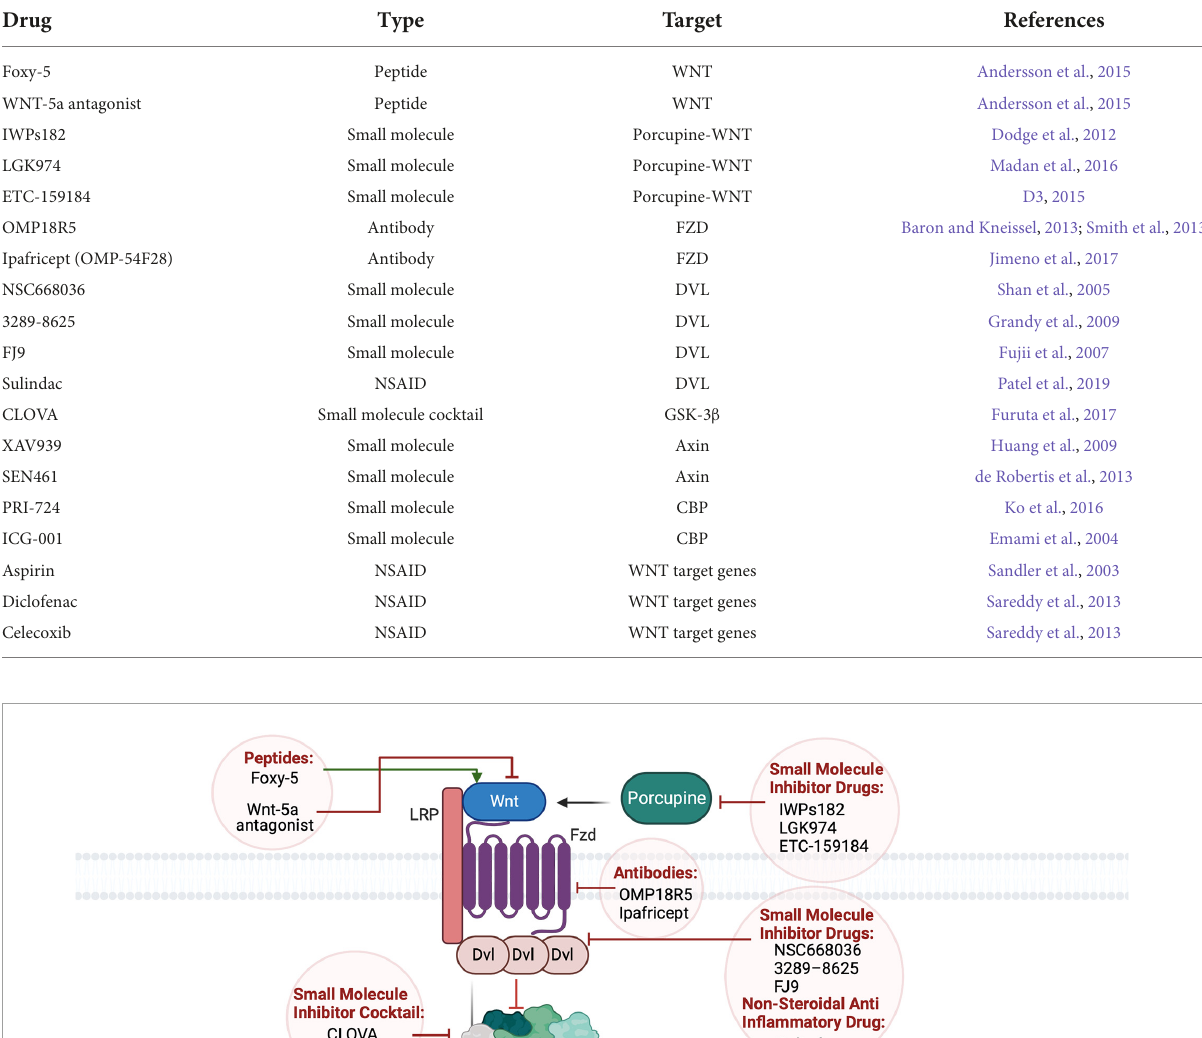
TABLE 3 Drugs targeting different components of WNT signaling.